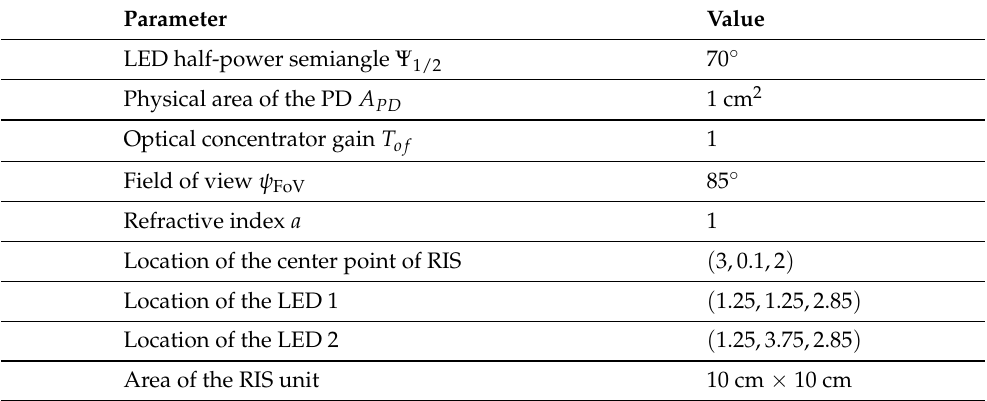
Table 1. Numerical parameters.